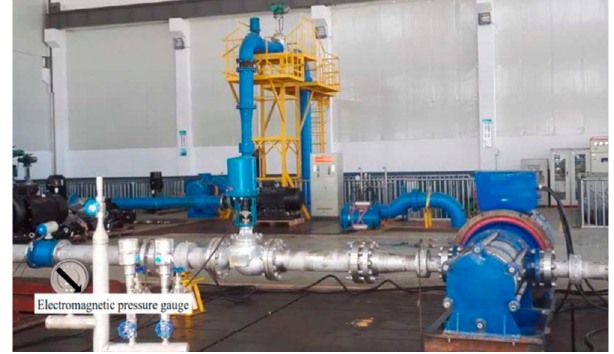
Figure 8. Test site map.